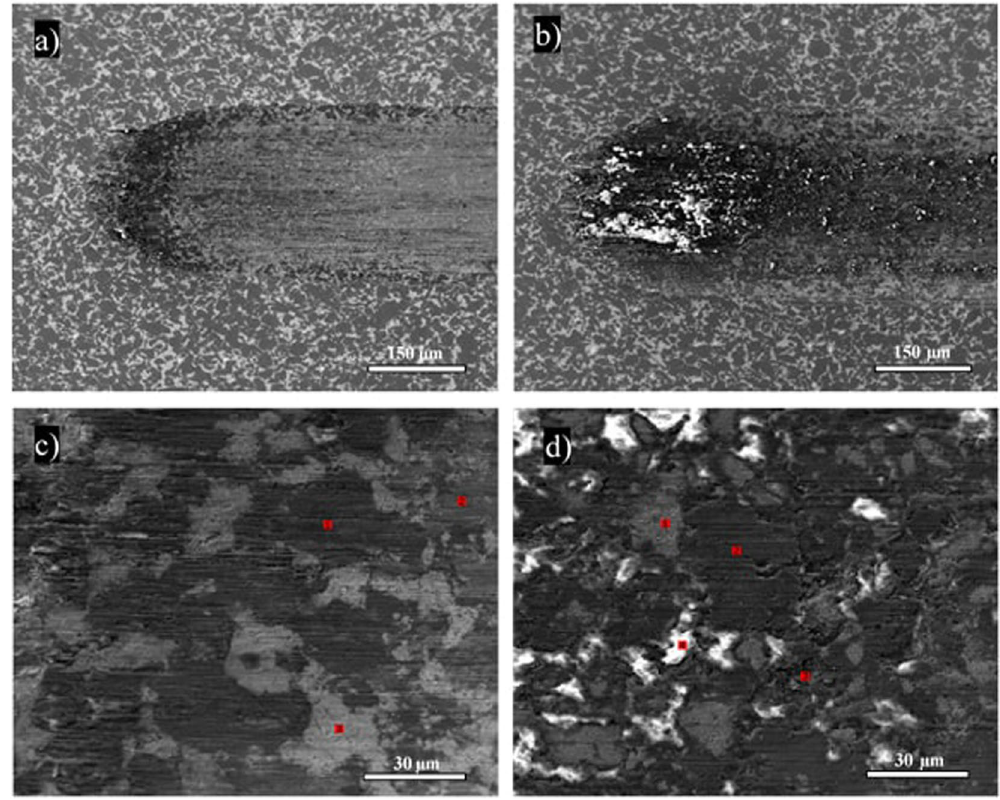
Figure 8. SEM images of the wear tracks on the 2H-WS 2 composite tested at 25 °C ( a , c ) and 100 °C ( b , d ).